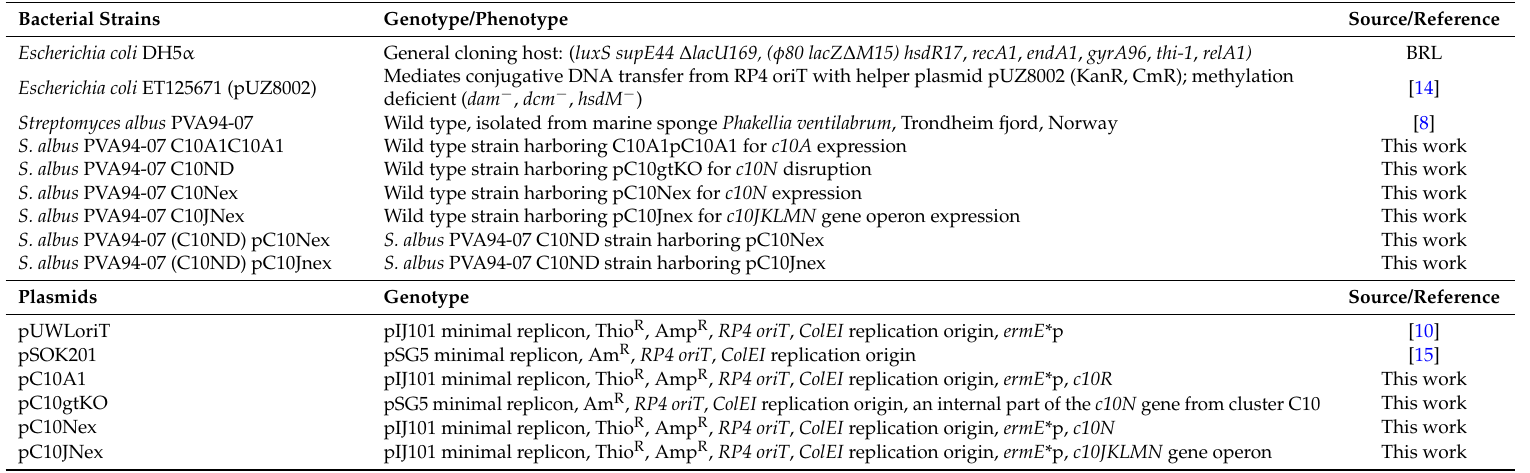
Table 2. Bacterial strains and plasmids used and/or constructed during this